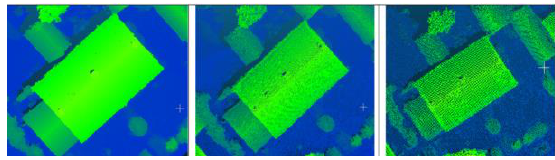
Figure 6. Original, half and quarter image scale point clouds